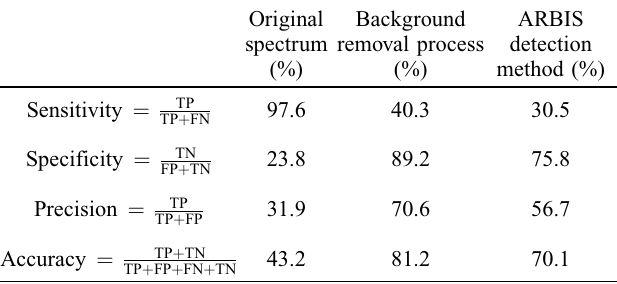
Fig. 20. Visualization of the different stages of the ARBIS system. Table 2. Performance results of the detection of type III bursts obtained by the proposed solar burst detection method and the ARBIS